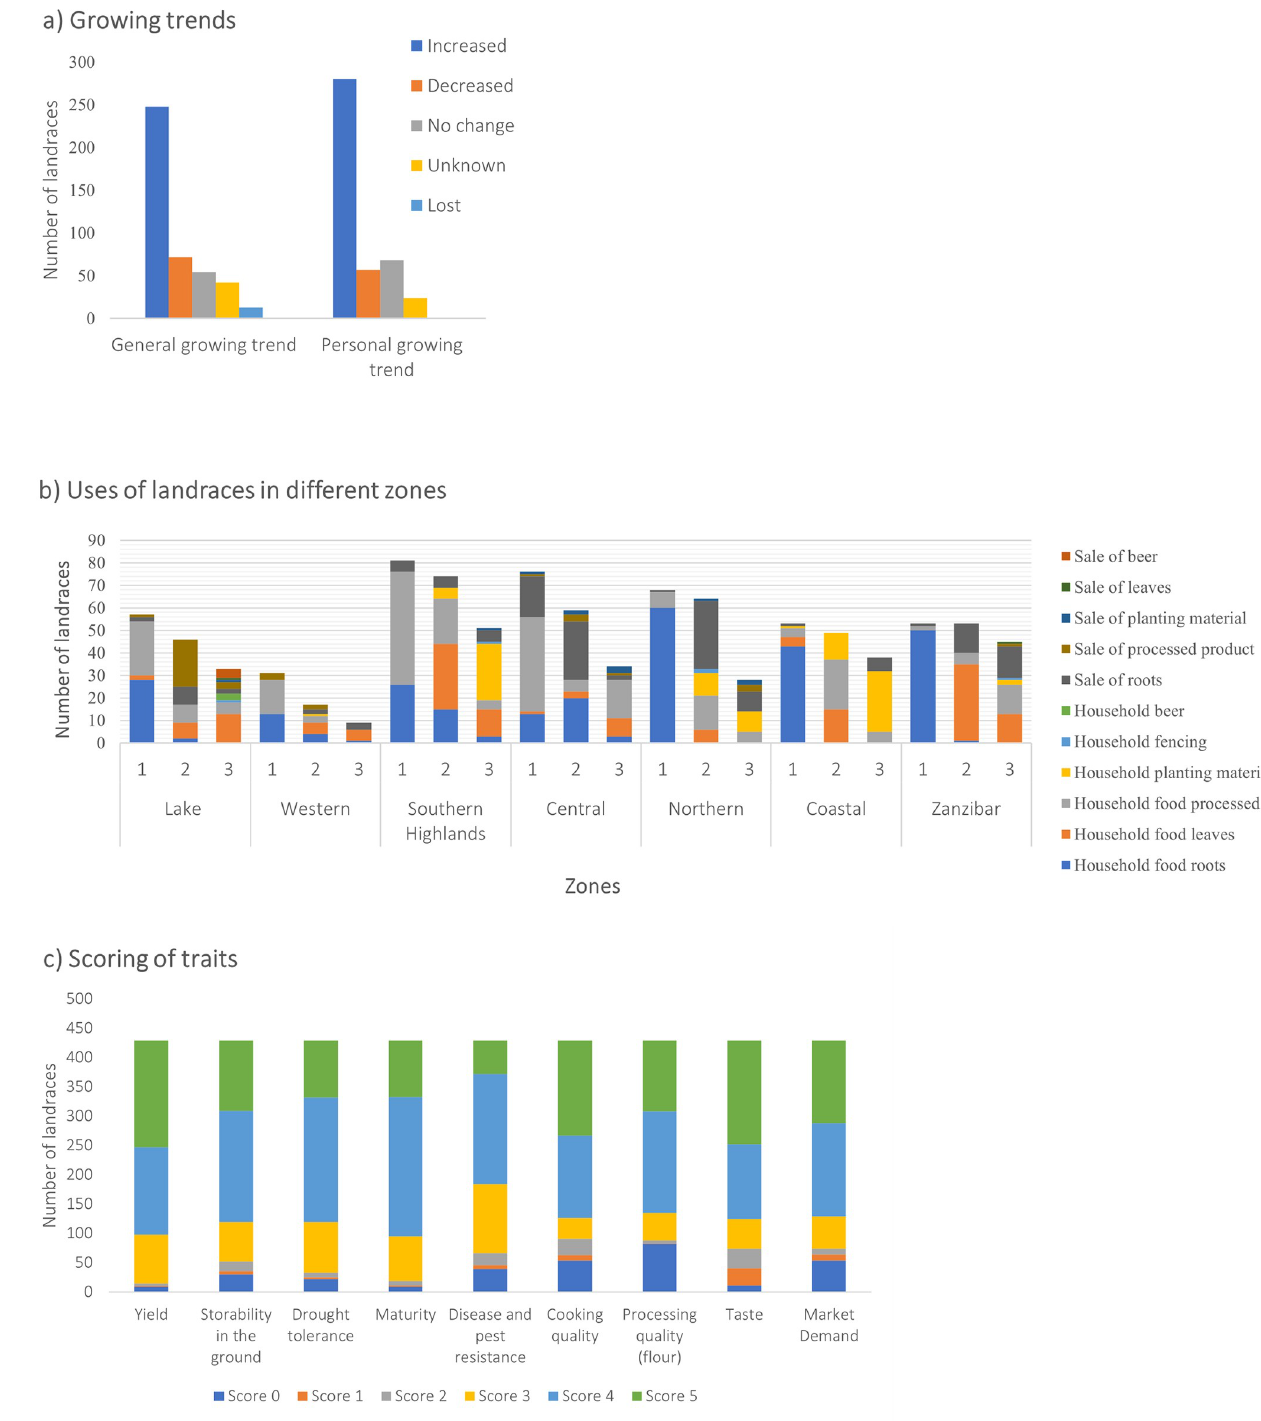
Fig 2. Tanzanian landraces show different growing trends, uses and trait scores: (a) General and personal growing trends of individual landraces; (b) Uses of landraces as first (1), second (2) and third (3) priority in different zones. ‘Household food roots’ equates to fresh consumption (raw, boiled or fried), whereas ‘household food processed’, means consumed as a flour; (c) Trait scores for landraces as rated by farmers where 0 = don’t know, 1 = very bad, 2 = bad, 3 = fair, 4 = good and 5 = very good. Data supporting Fig 2B, is provided S7 File.